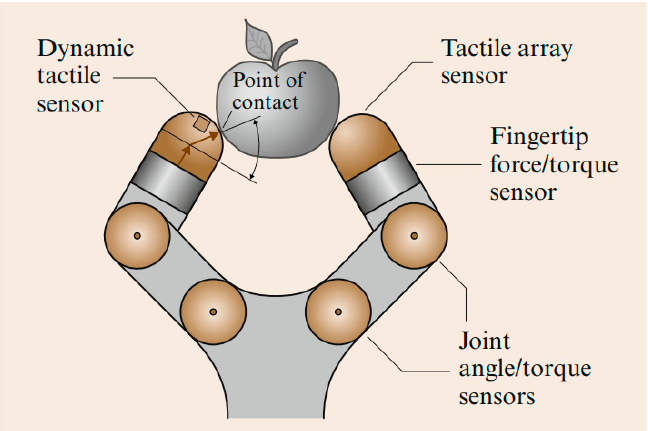
Figure 2. Robot hand with fingertip force and tactile sensing. Information from the force sensors can be combined with knowledge of fingertip geometry to estimate contact location, referred to as intrinsic tactile sensing. Reprinted/adapted with permission from Ref. [14]. Copyright 2008, Springer.